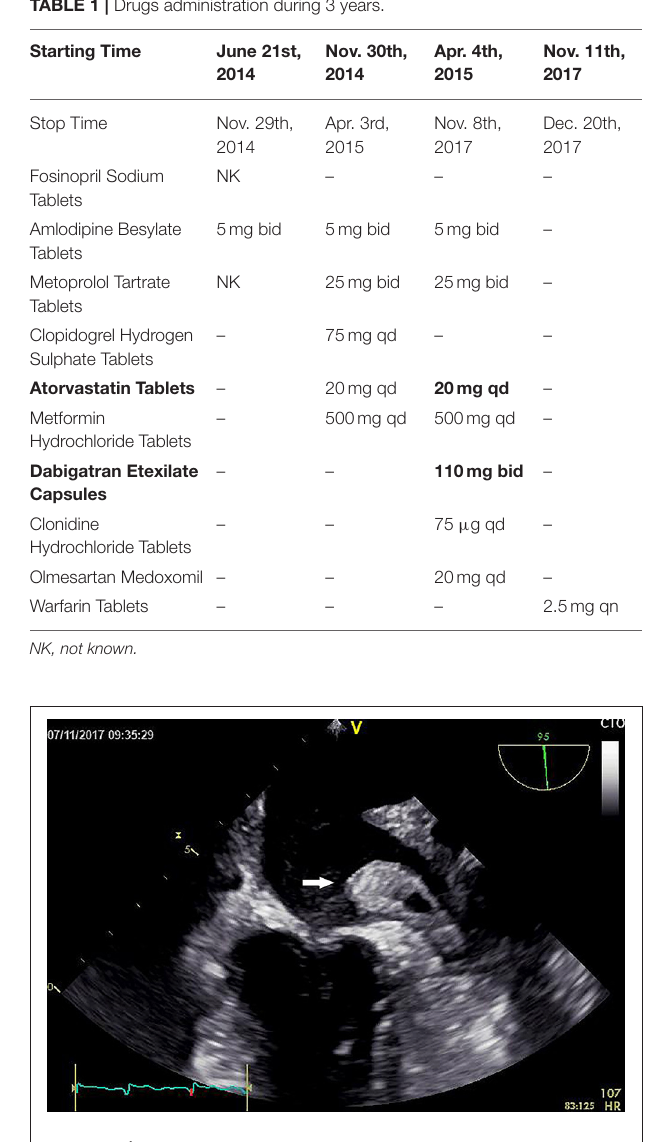
temporary pacemaker implantation in November 29th,